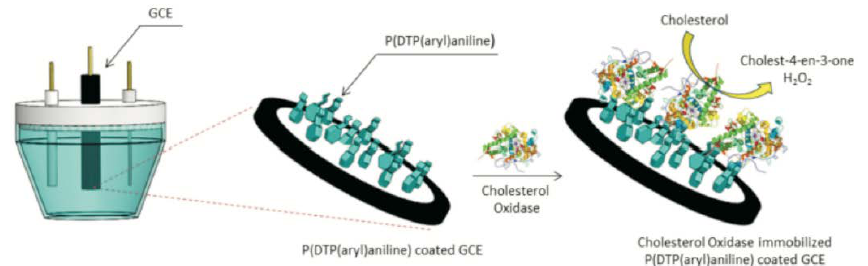
Figure 5. Preparation of a DTPPy(aryl)PPyA/ChOx electrode [220]. Reprinted with permission from Reference [220]. Copyright 2019 John Wiley & Sons.